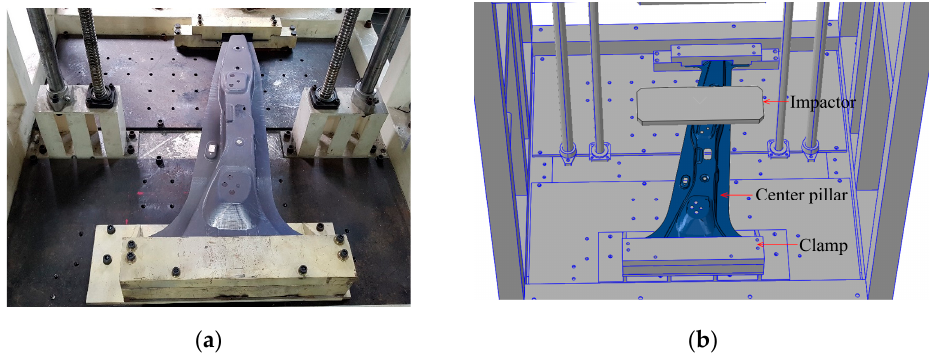
Figure 3. Boundary conditions for the drop weight test: ( a ) experiment; ( b ) simulation. Table 3. Boundary conditions of the simulation for the drop weight test.